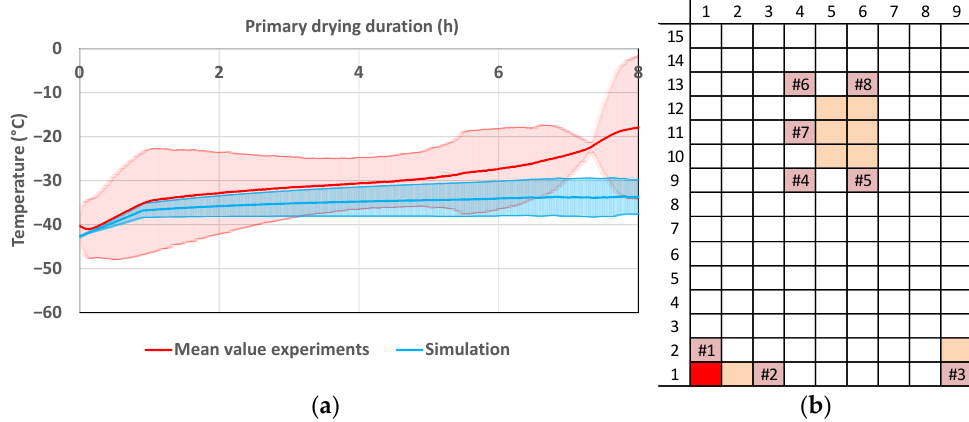
Figure 12. ( a ) Product temperature profile of vial 1.1 during primary drying at the CP. ( b ) Vial position (red: shown vial, orange: other probed vials, pink: WTMplus sensor position and WTMplus number).